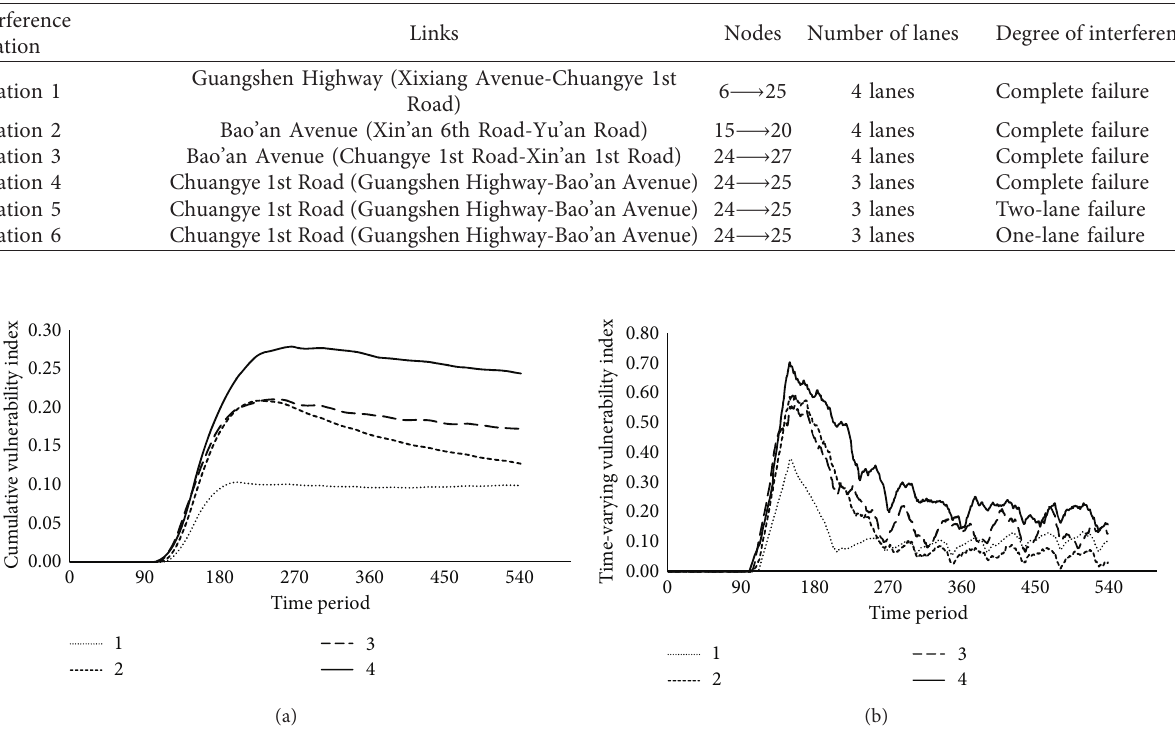
Figure 5: Vulnerability variation diagram under link complete failure. (a) shows the cumulative vulnerability when the main section of the Bao’an Central Area completely fails, and (b) shows the time-varying vulnerability. (a) Cumulative vulnerability. (b) Time-varying vulnerability.